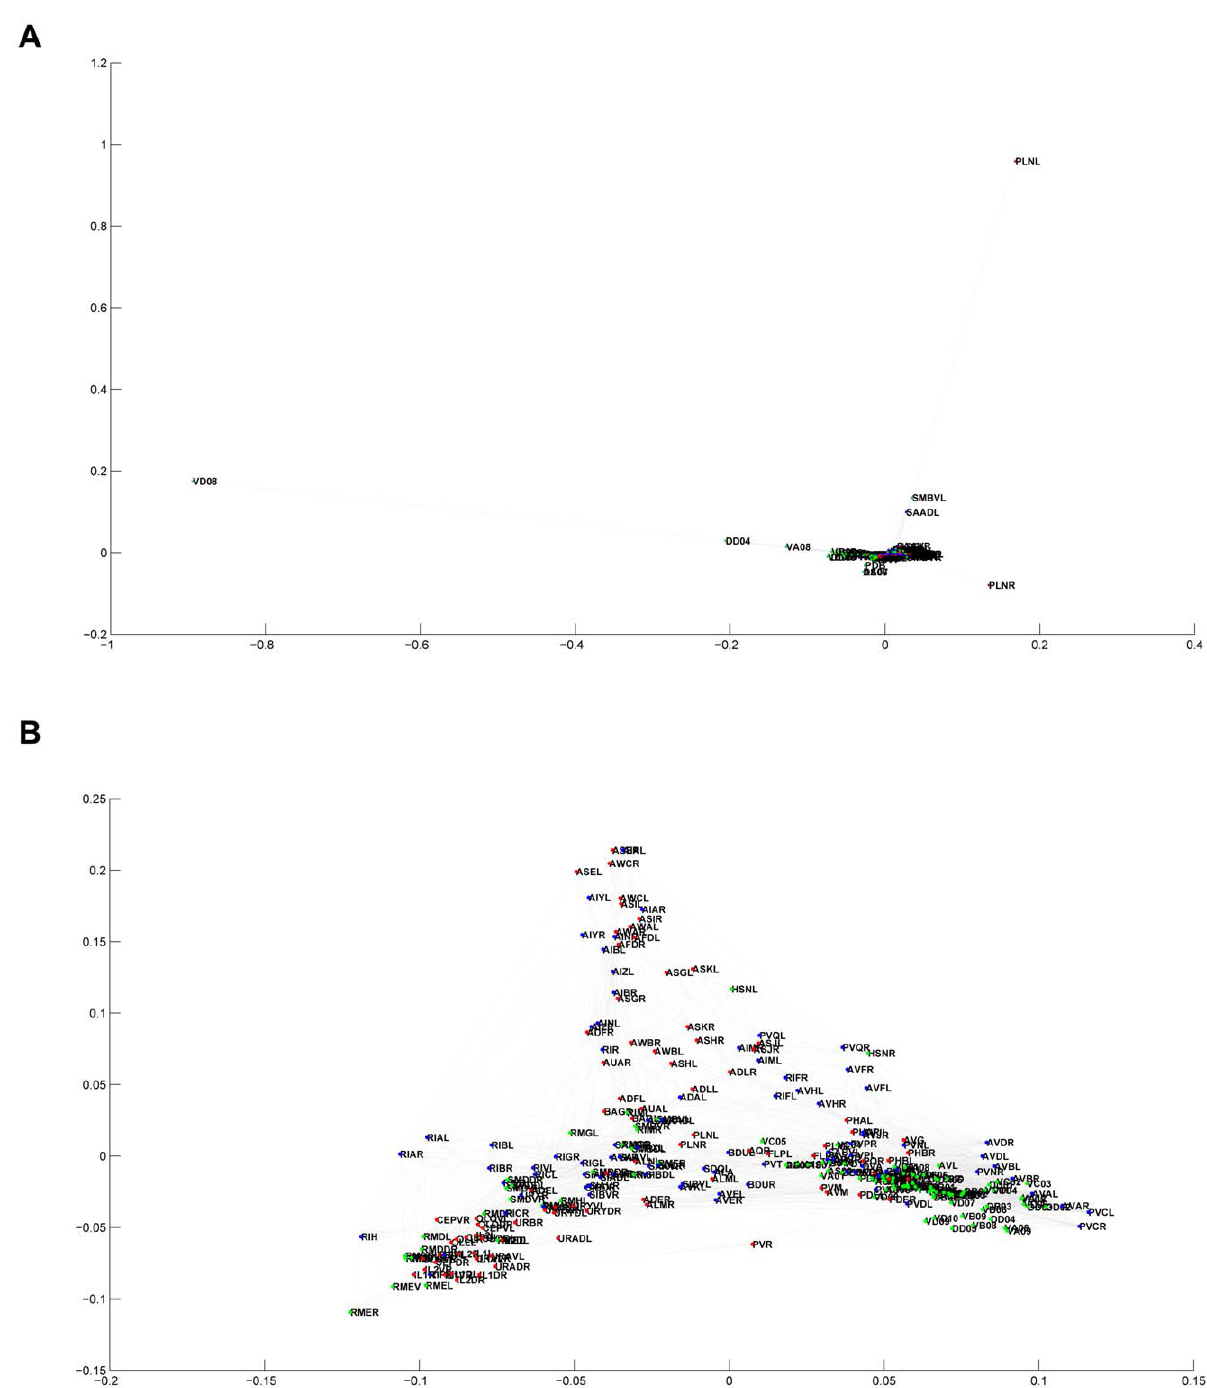
Figure 5. Normalizing the Laplacian C. elegans neural network: (a) Un-normalized Laplacian, ( Q 2 , Q 3 ) (b) Normalized Laplacian ( Q 2 , Q 3 ) .